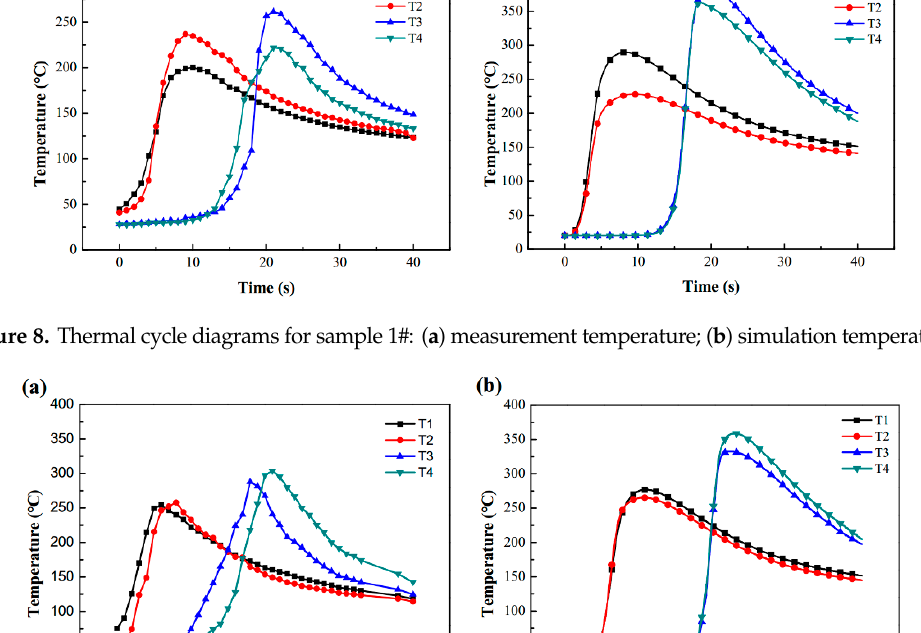
Materials 2020 , 13 , x FOR PEER REVIEW Figure 7. Comparison among calculated results and experimental results (Sample 2#).